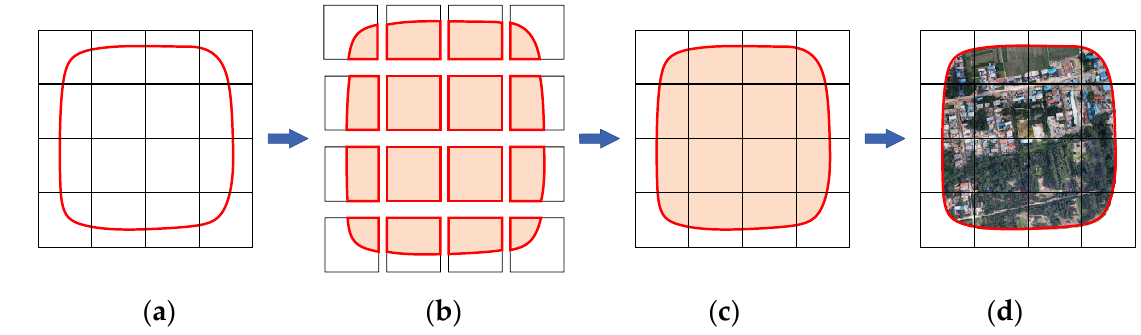
Figure 1. Basic principle of reconstruction using the Han method. ( a ) Partitioning grid; ( b ) mesh reconstruction; ( c ) mesh merging; and ( d ) texture reconstruction.